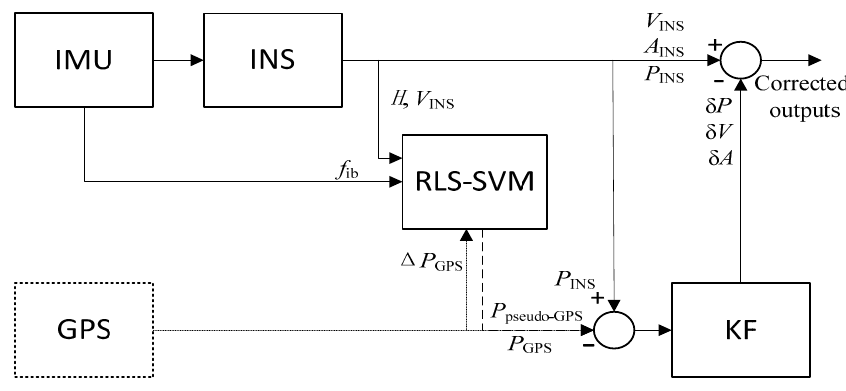
Figure 1. RLS-SVM aided INS/GPS integrated navigation system.